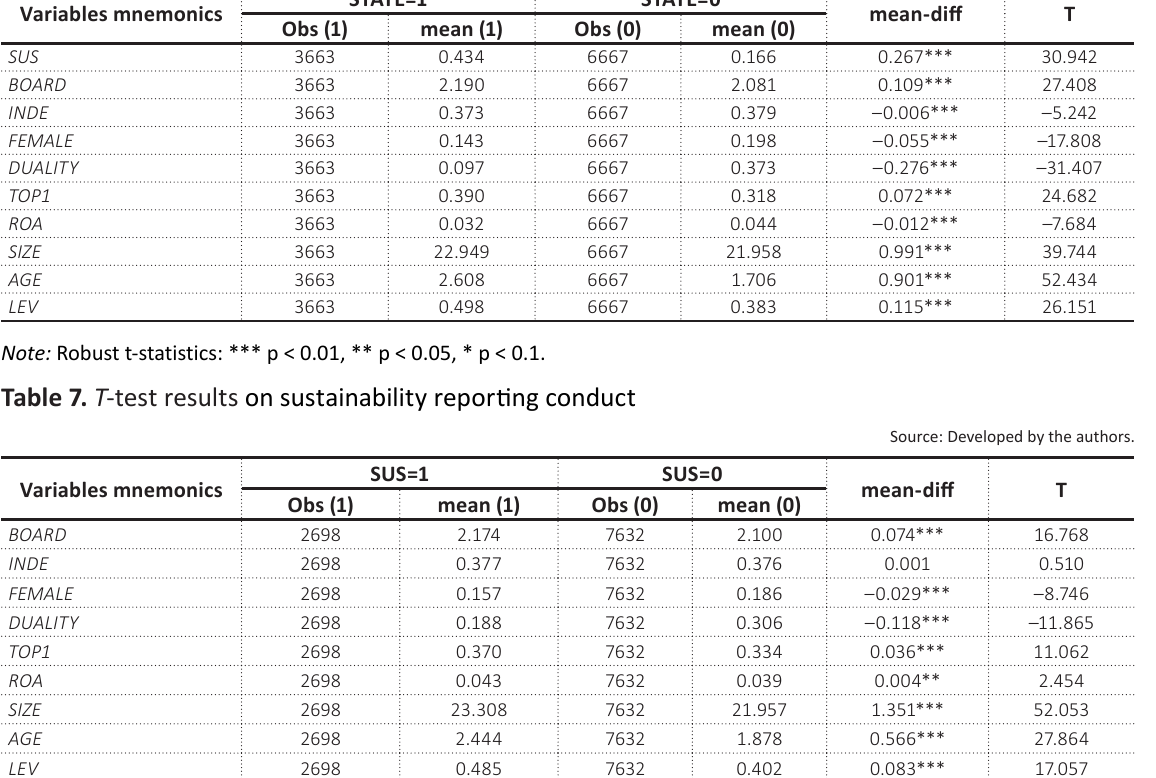
Table 6. T -test results on type of property rights holder